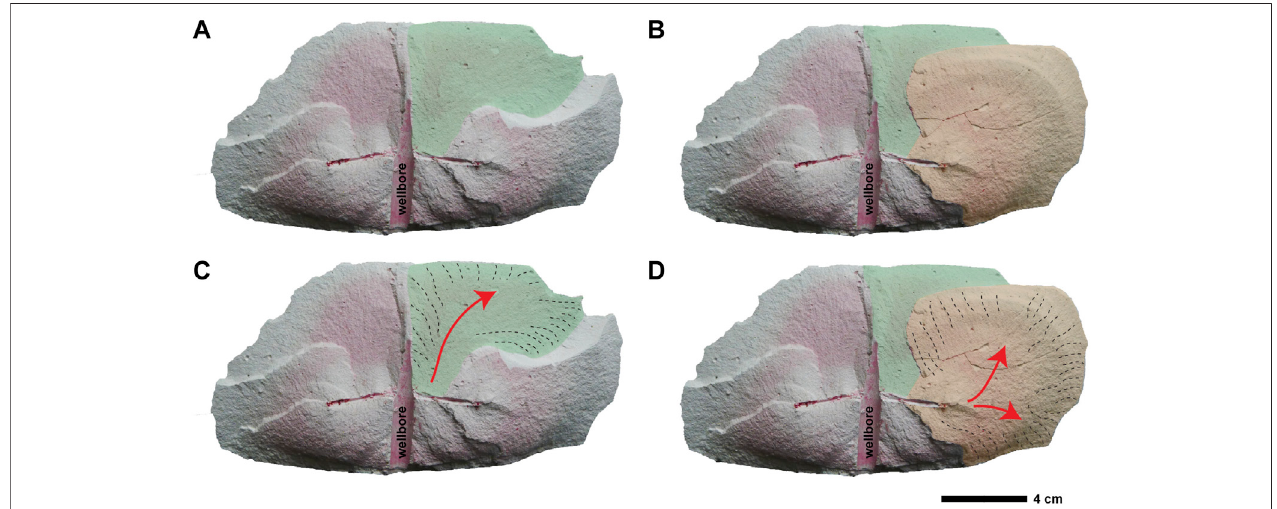
FIGURE 12 | Block 20, Fracture 4 showing multiple fracture segments that grew from the wellbore perforations. Part (A) shows one fracture that appears to have grownupwardfromthewellboreandthenpropagatedalongacurvedpath(highlightedingreen)while (B) showsasecondfracture(highlightedinorange)thatappearsto grow both downward and upward from the perforation to overlap and link with the green-highlighted fracture. Parts (C,D) show these fractures with annotations for fracture growth direction (in red) and fracture plumose marks highlighted using black dashed lines.